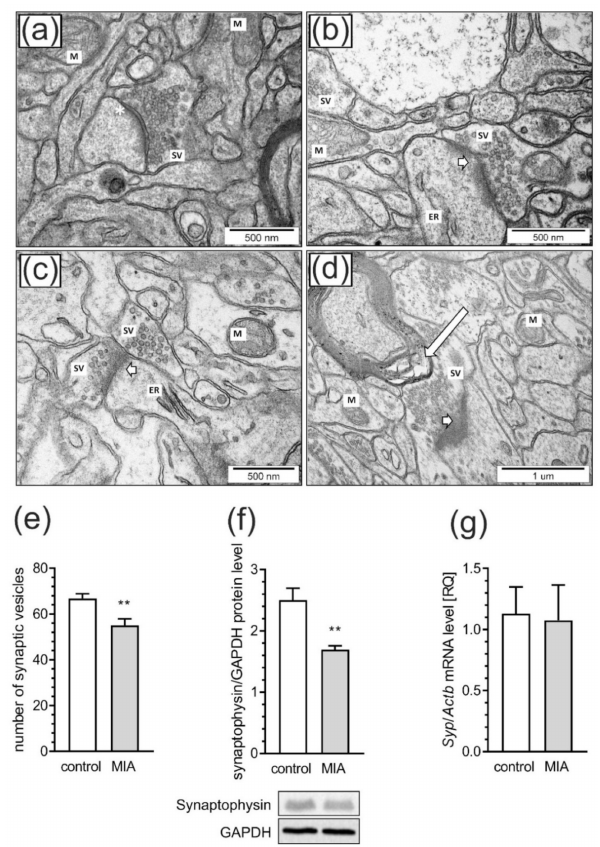
Figure 9. MIA evokes synaptic alteration in rat brain cortex. The e ff ects of prenatal LPS exposure on ultrastructural changes of synapses in male o ff spring at PND 52 were examined in the somatosensory cortex by transmission electron microscopy. Representative pictures were presented (Figure a – d ). In the control group ( a ), normal structure of neurons, neuropil, well-defined structure of synapses with accurate post-synaptic density (asterisks), distribution of synaptic vesicles (SV), and well preserved mitochondria (M) were observed. In the MIA group ( b – d ), observations include features of neurons and neuropil swelling, reduced packing density of SV in the presynaptic area, blurred structure of synaptic cleft without clearly marked pre- and postsynaptic membranes (short arrows on Figure b – d ). Moreover, disturbed synaptic membrane, ultrastructural changes in mitochondria with blurred cristae structure (M on Figure b , c ), changes in myelin structure (long arrow on Figure d ) and swollen endoplasmic reticulum (ER on Figure b ) were present. ( e ) Quantitative analysis of synaptic vesicle numbers. ( f ) Densitometric analysis of synaptophysin normalized to GAPDH immunoreactivity with representative Western blot. ( g ) Gene expression of Syp as measured by real-time PCR and normalized to Actb ( β -actin). Data represented the mean value ± S.E.M. (e–n = 4, f–n = 6–9, g–n = 3–4) for ultrastructural analysis and n = 6 for gene expression and protein levels. Data were analyzed using Student’s t -test. ** p < 0.01 compared to control